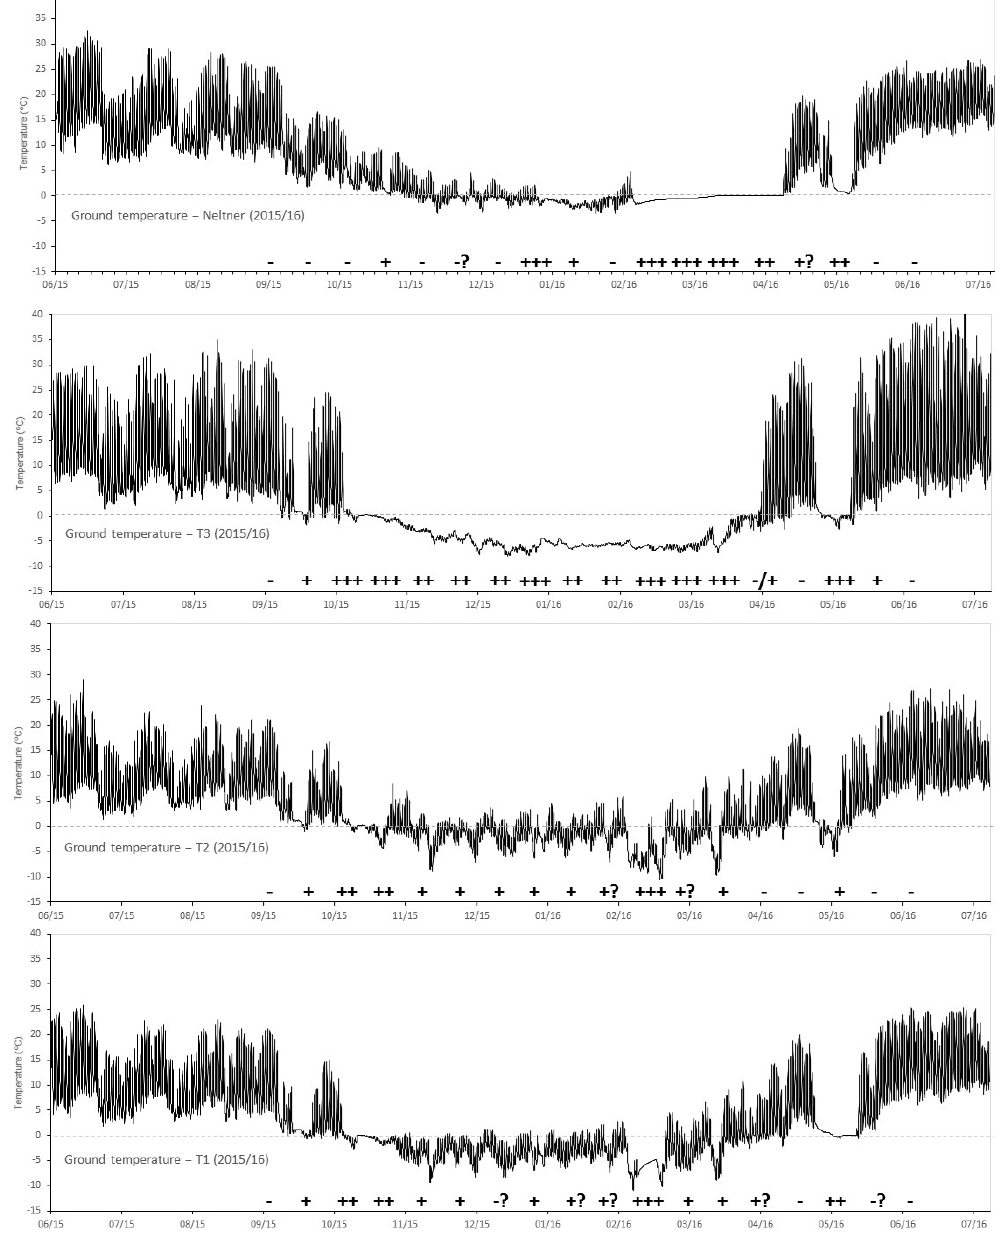
Figure 11. Ground surface temperature regimes at the four sites in the Toubkal massif. The plot shows hourly data. Symbols indicate the snow cover conditions at the date of satellite scenes: − , no snow; + , possible snow/snow margin; ++ , snow; +++ , significant snow; ?, uncertainty in